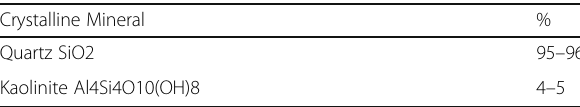
Table 1 Quantitative XRD Analysis for Pindan